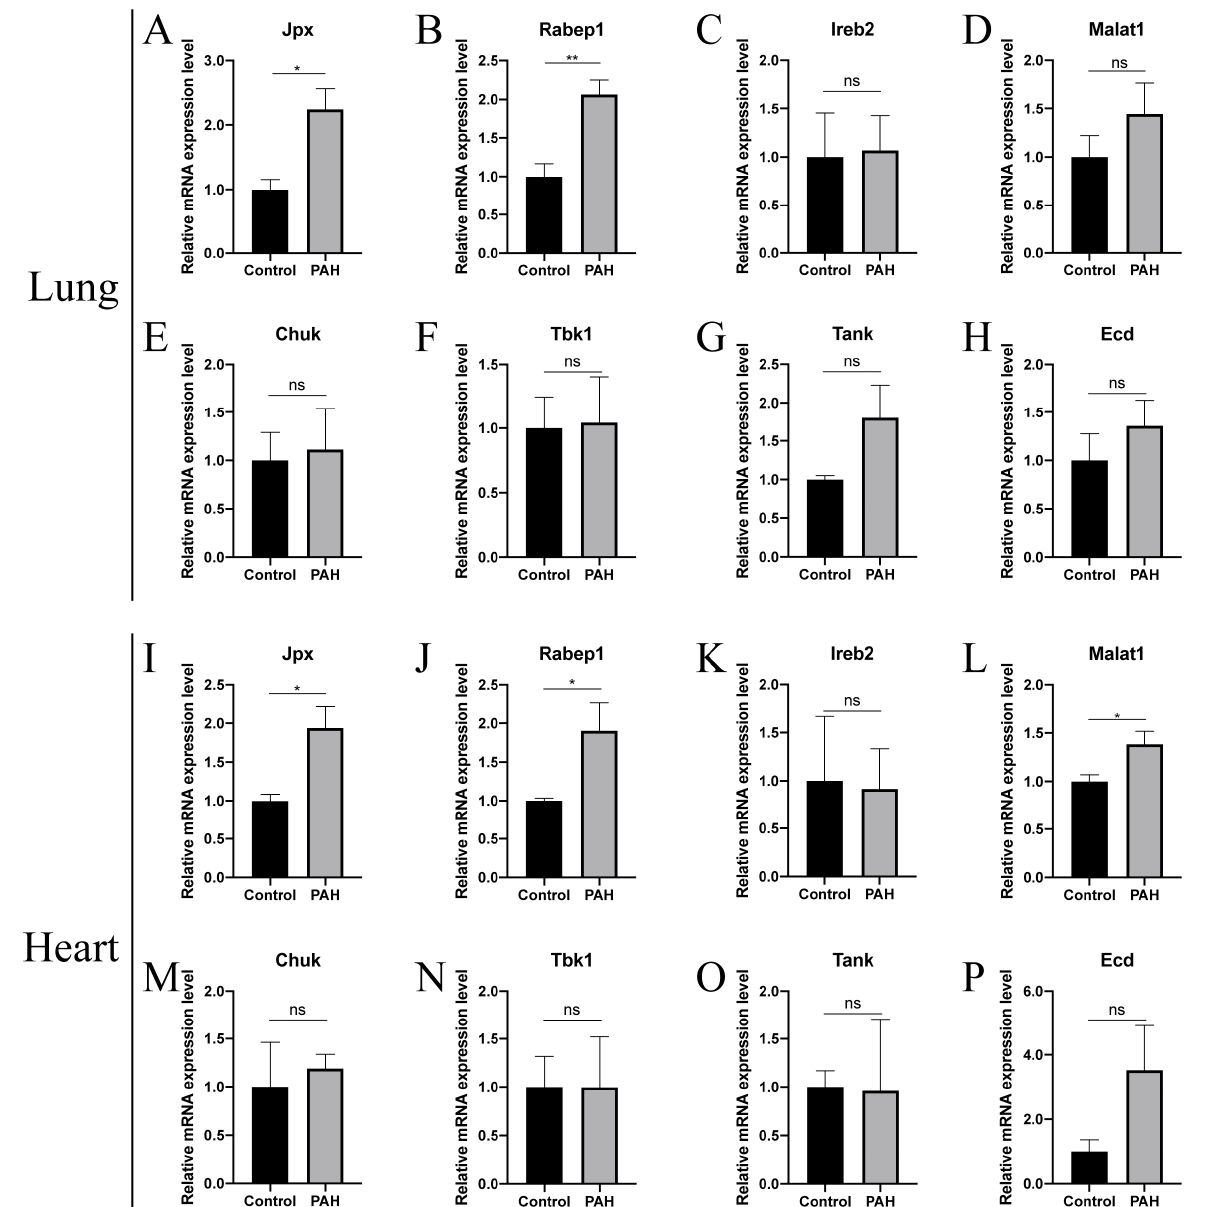
Figure 6. Expression of lncRNA-mRNA pairs in animal model. ( A – H ) Expression of lncRNA-mRNA pairs in lung tissues. ( I – P ) Expression of lncRNA-mRNA pairs in heart tissues. PAH, Pulmonary arterial hypertension; Control, normal tissues; ns, no significance. * p value < 0.05, ** p value <